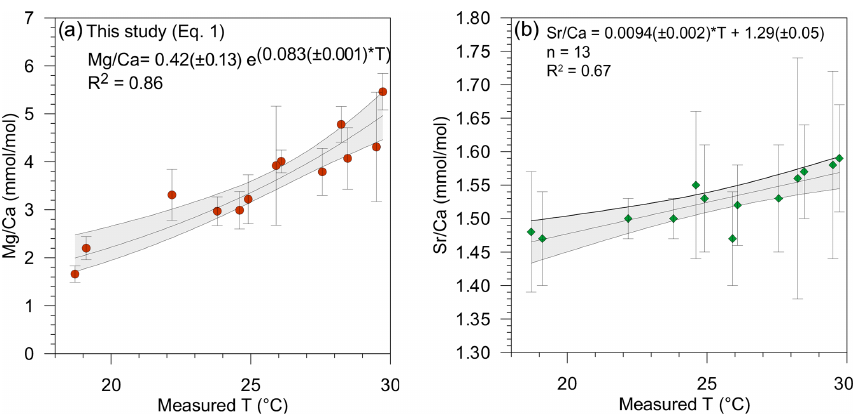
Figure 2. (a) Mg / Ca and (b) Sr / Ca (mmolmol − 1 ) and 95% confidence intervals plotted versus measured surface temperature ( ◦ C). Each point represents an average of the Mg / Ca and Sr / Ca per